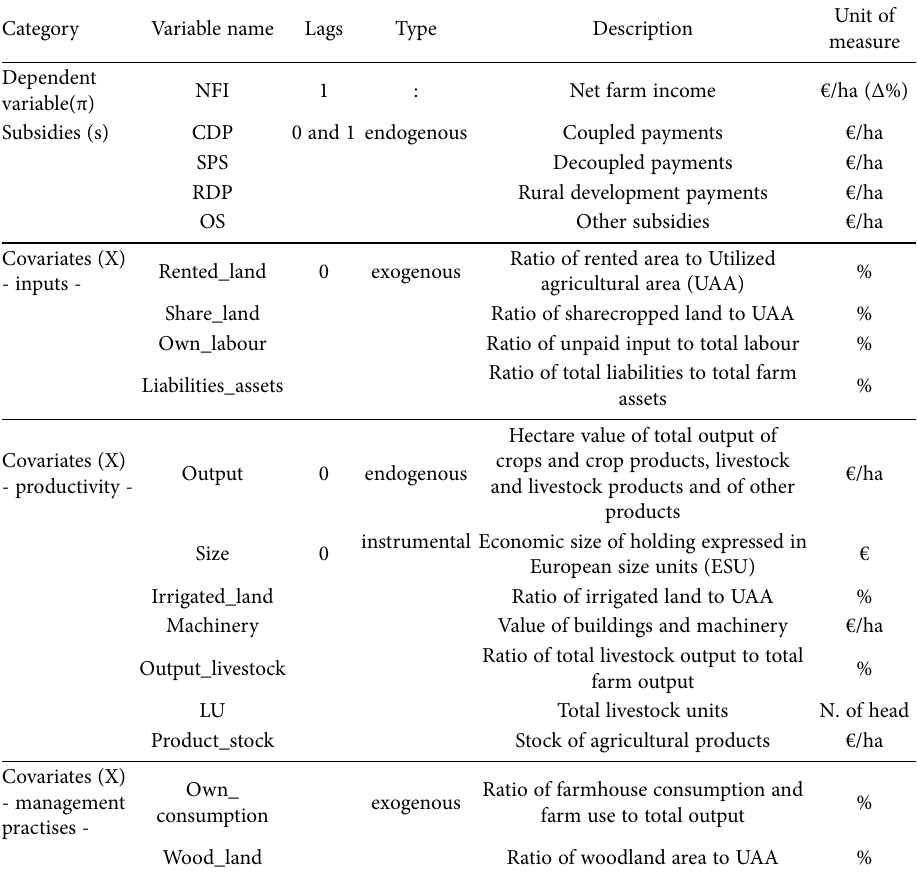
Table 1. List of